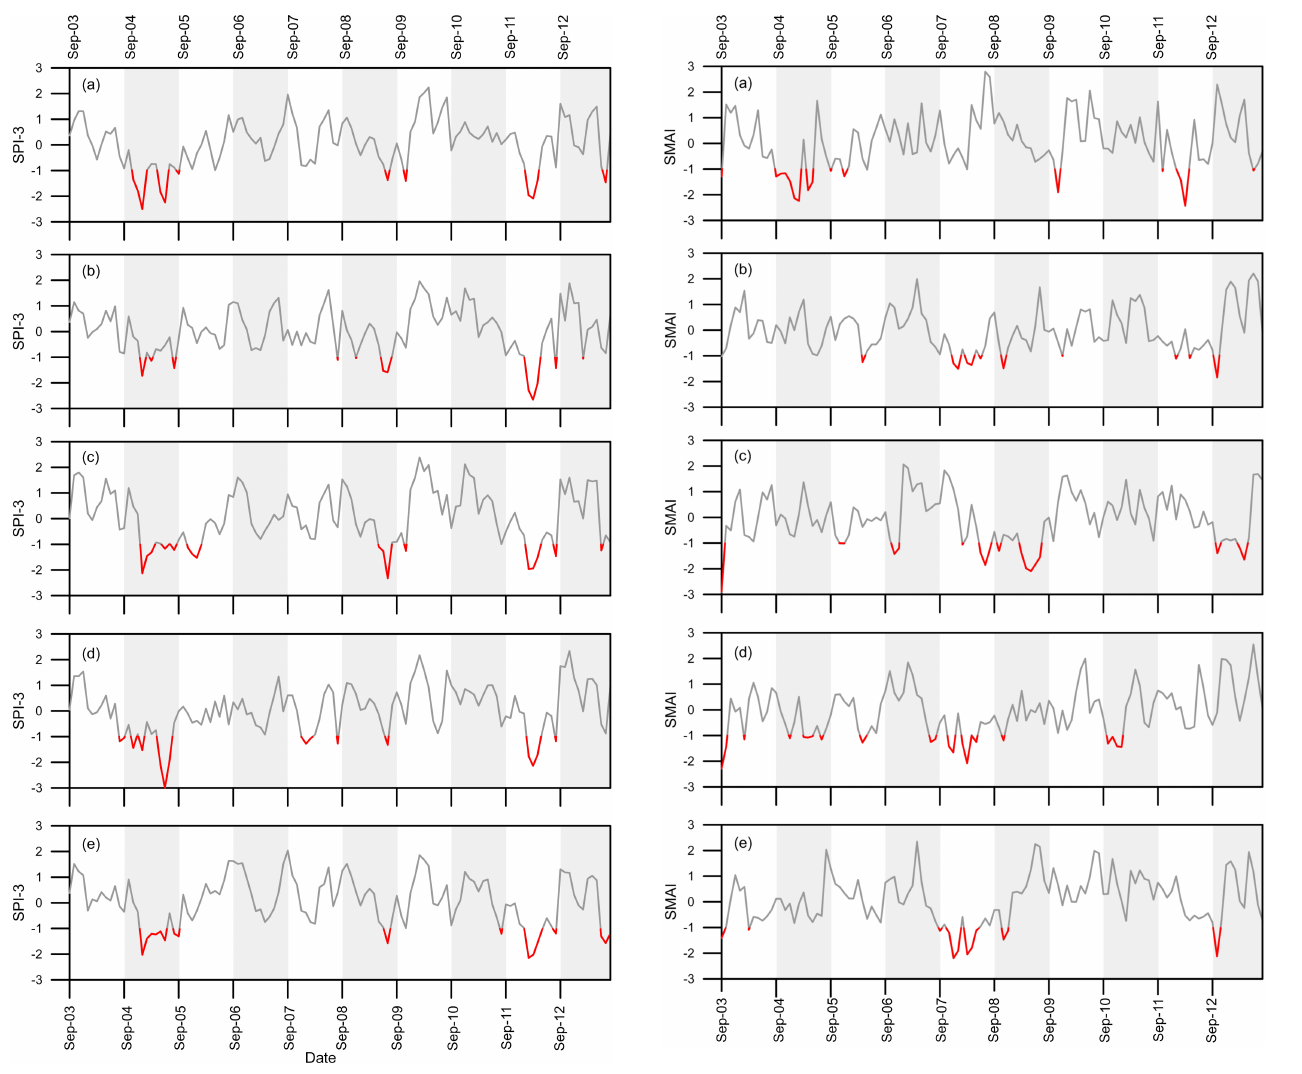
Figure 2. Variation of the standardized precipitation index over 3 months (SPI-3) during the period studied (2003–2013) in the five selected agricultural regions: (a) Campiña de Cádiz, (b) Campiña Baja, (c) Pedroches, (d) Norte/Antequera and (e) La Campiña. Red lines indicate values below the defined threshold of − 1.